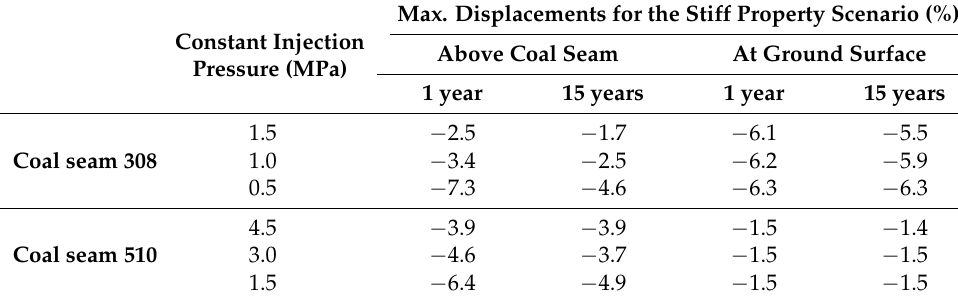
Figure 10. Maximum vertical displacements ( a ) above the respective coal seams as well as ( b ) the ground surface compared for the scenarios with soft and stiff rock properties for the operational state (1 year). Table 4. Percentage deviation in maximum displacements between the soft and stiff rock property